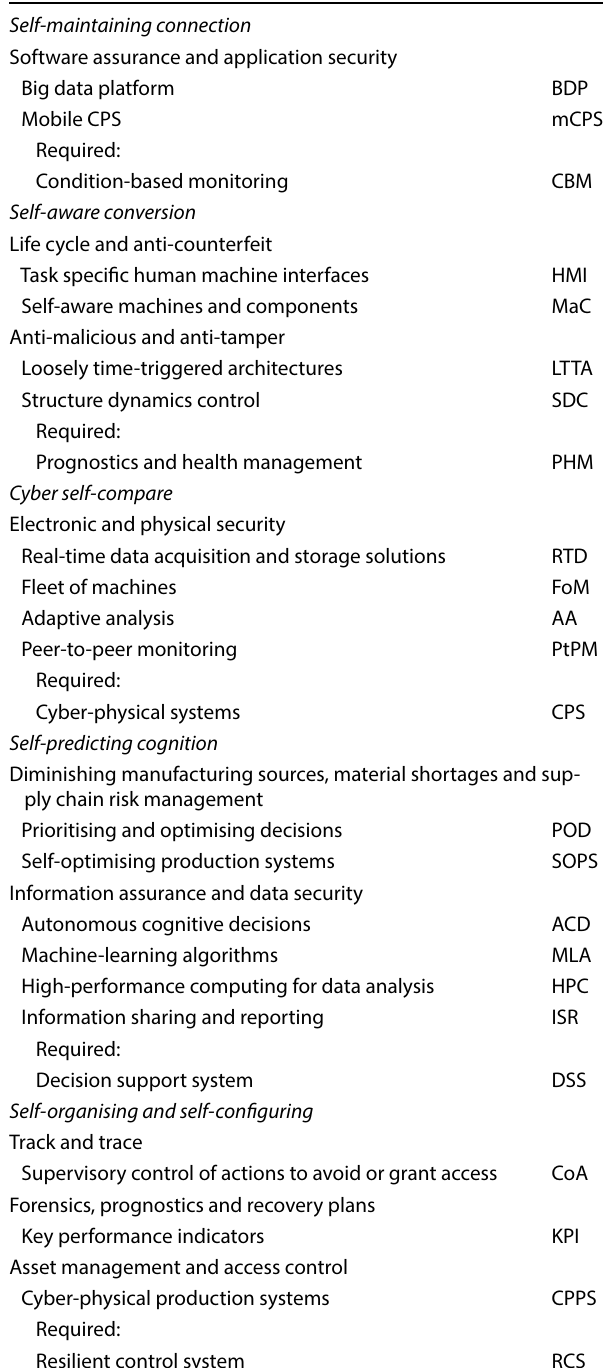
Table 2 Taxonomy of requirements for artificial intelligence for CPS in manufacturing and ‘servitization’ Self-maintaining